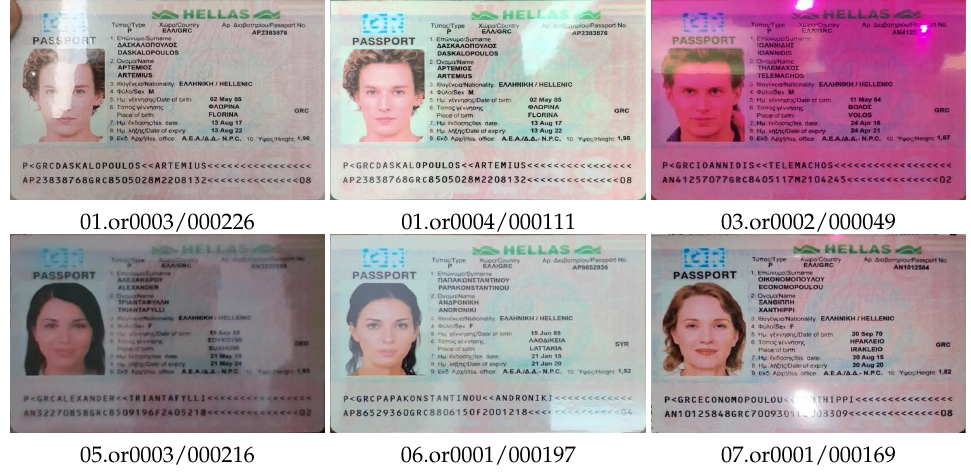
Figure 5. Reflections caused by the lighting condition on the surface of laminated documents, type